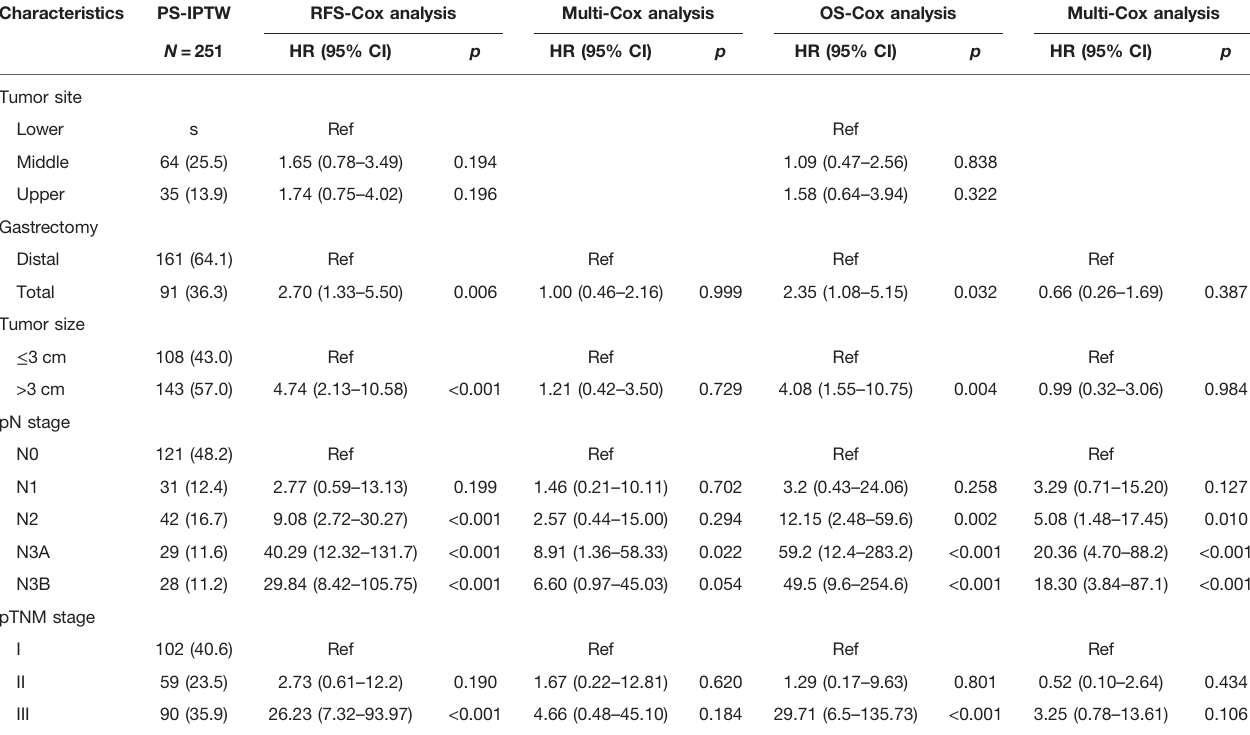
TABLE 3 | Multivariate Cox analysis after